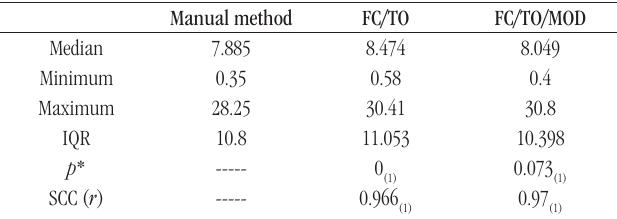
taBLE − Comparison between the results yielded by different methods of automated reticulocyte count and the manual